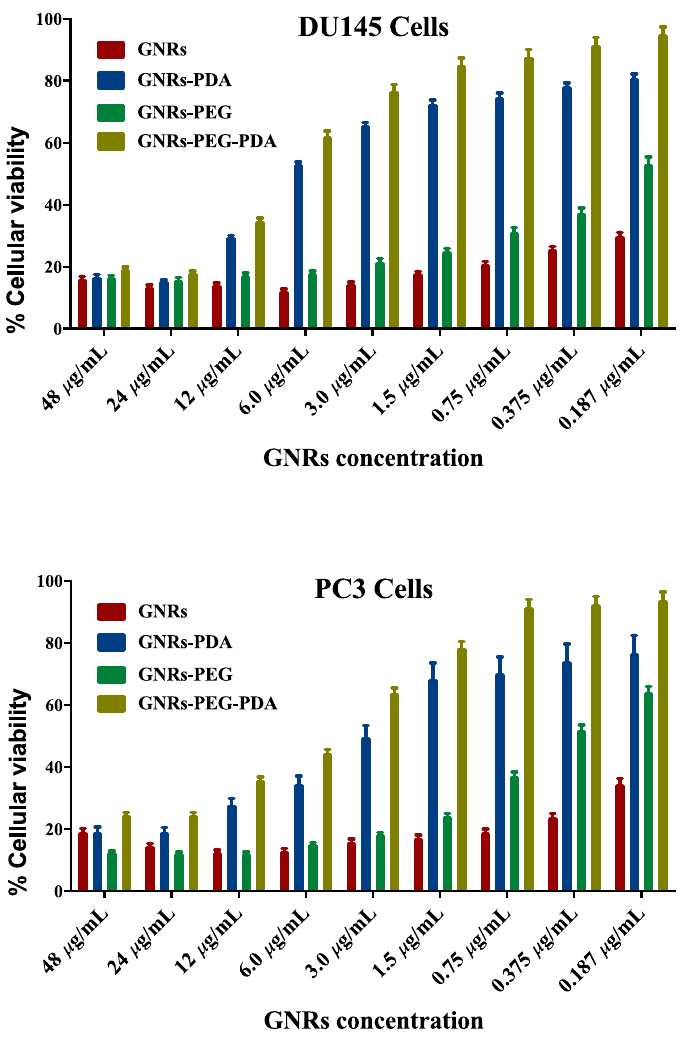
Figure 6. Cellular viability of PC3 and DU-145 prostate cancer cell lines upon incubation with GNRs, GNRs-PEG, GNRs-PDA and GNRs-PEG-PDA for 72 h. GNRs-PEG, GNRs-PDA and GNRs-PEG-PDA for 72